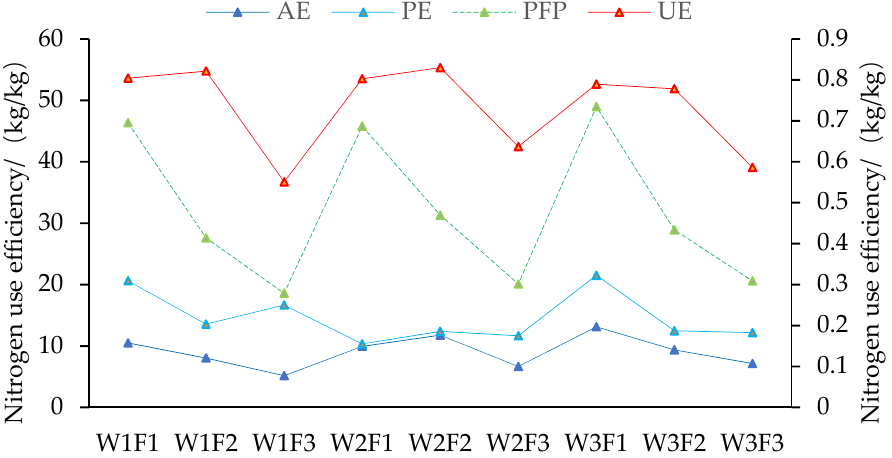
Figure 6. The nitrogen use efficiency of winter wheat. Note: solid line readings are based on the primary vertical coordinate (left), dashed line readings are based on the secondary vertical coordinate (right).